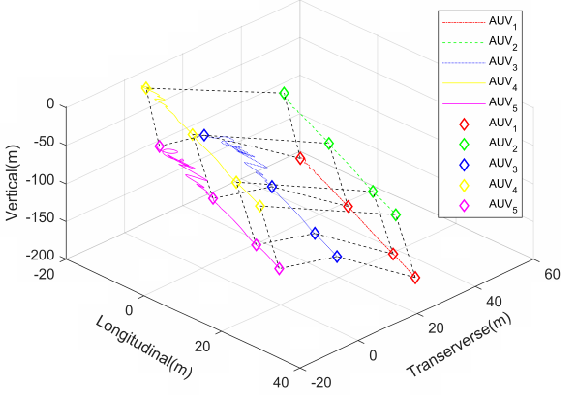
Figure 8. The 3D trajectory of the multi − AUV